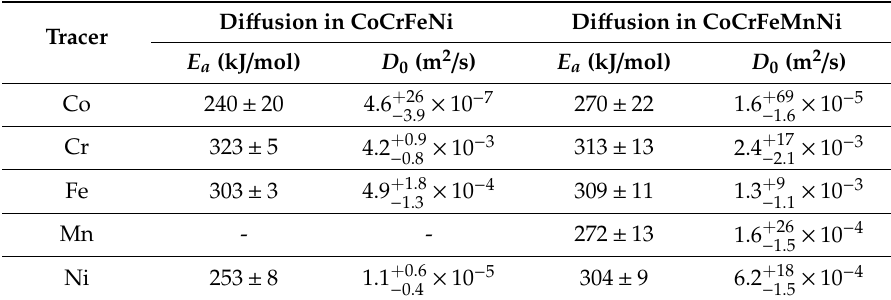
Table 7. Activation energies E a and the pre-exponential factors D 0 for bulk diffusion of the constituents in CoCrFeNi and CoCrFeMnNi [39].